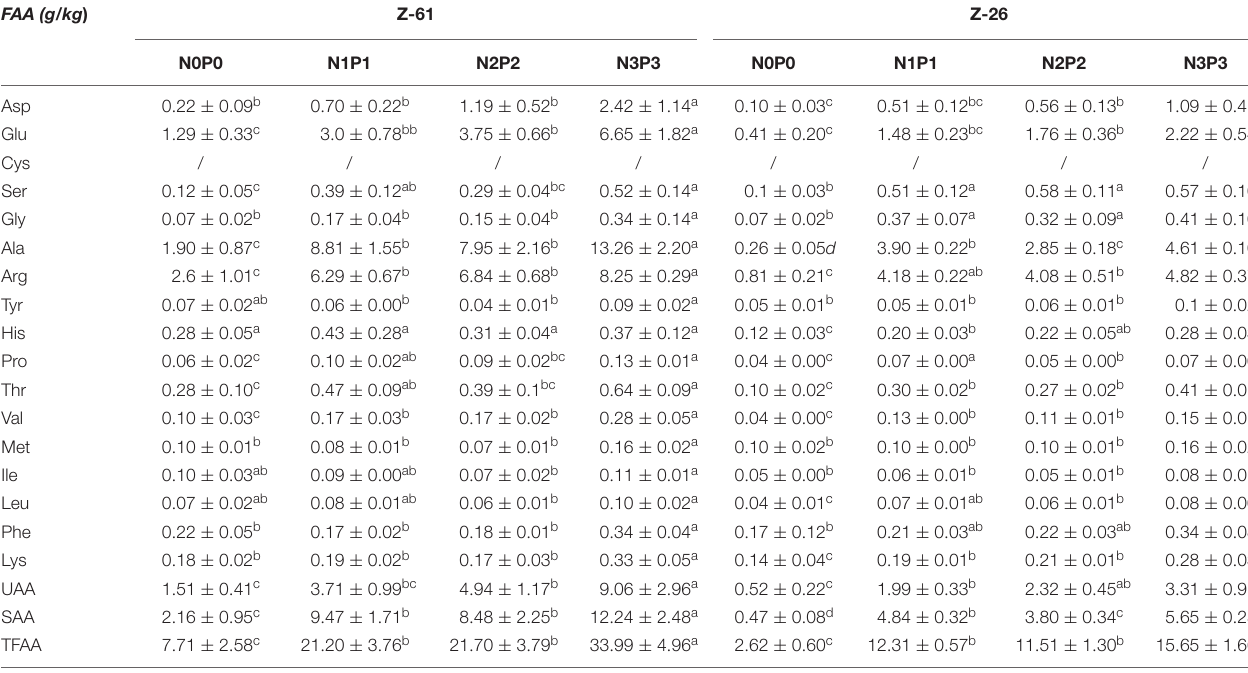
TABLE 3 | Free amino acid contents (g · kg − 1 dry weight) in thalli of Z-61 and Z-26 cultured under different nutrient levels. FAA (g/kg